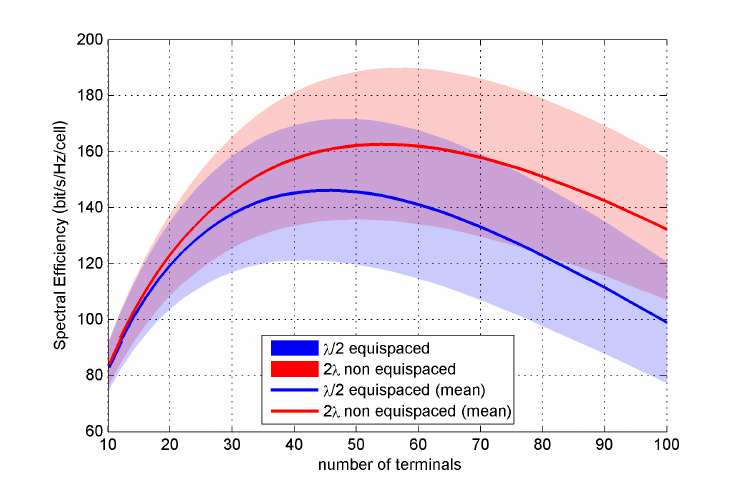
Figure 21. Average maximum achievable ZF rate as a function of the number of user terminals K ; the areas represent the range of the standard deviation with respect to the